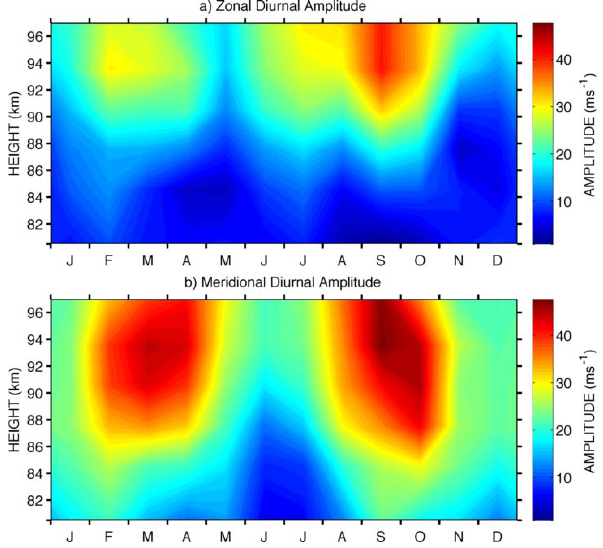
Fig. 6. Composite-year monthly-mean diurnal tidal amplitudes as a function of month and height over Ascension Island for all data recorded from January 2002 to June